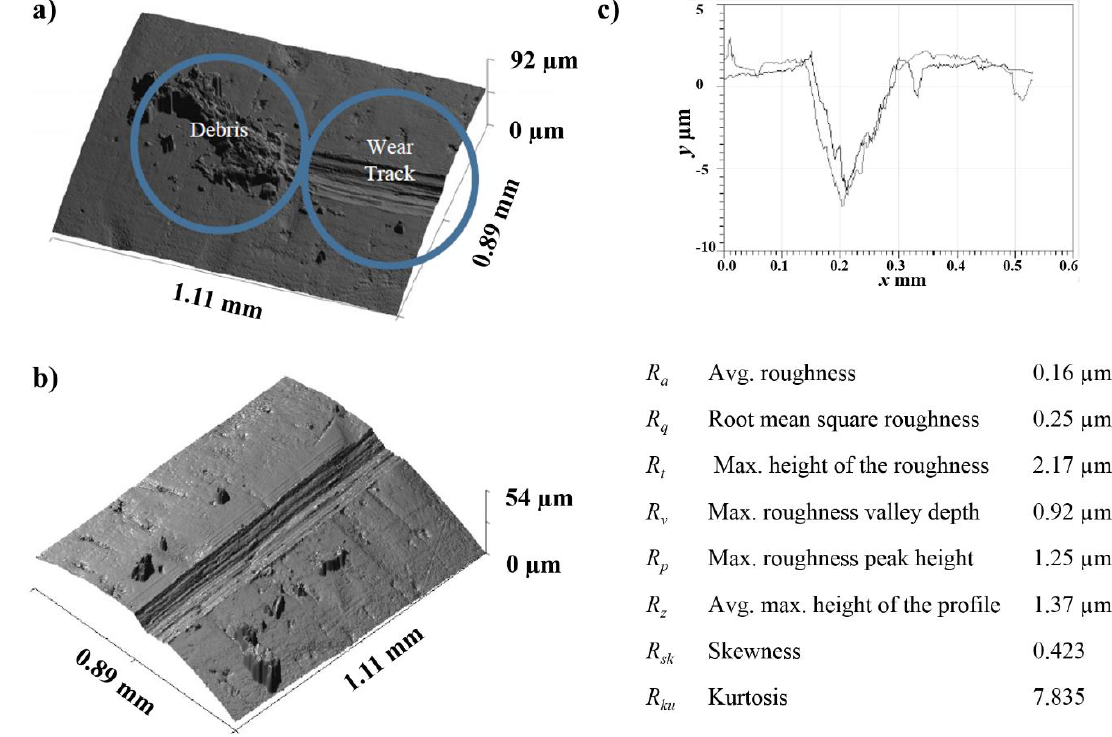
Figure 12. Surface analysis at 5 N load and 10 Hz fretting frequency. ( a ) Oxide and metallic debris accumulated at the end of the wear track of the contact interface. ( b ) The 3D surface profile of the wear track on the Ag-coated connector. ( c ) An illustration of the 2D wear track profile, and the roughness amplitude parameters averaged from five random locations on the wear track.